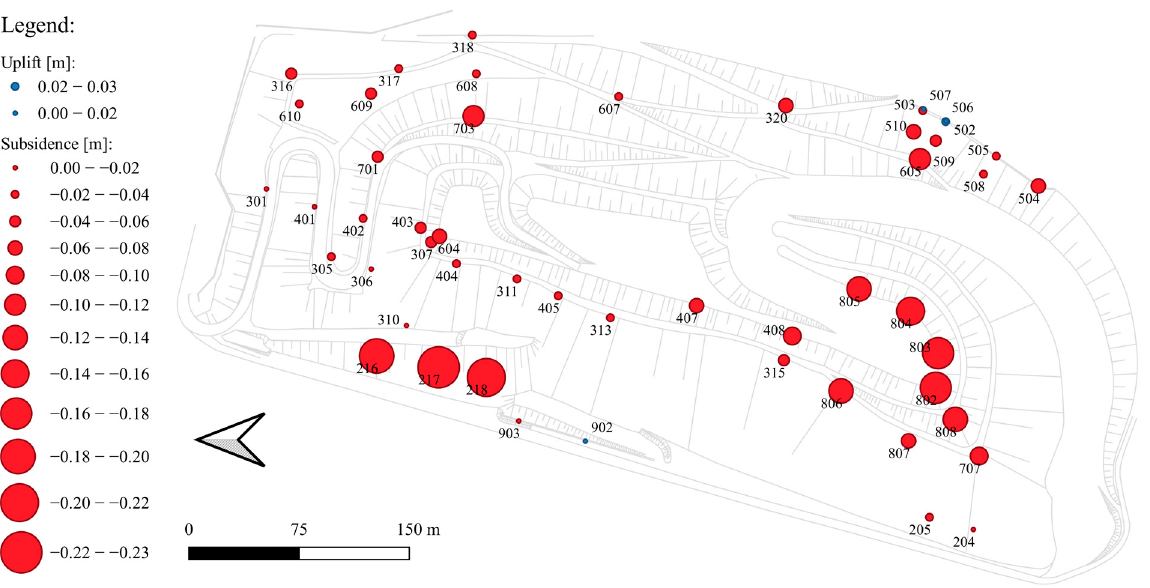
Figure 2. Map of annual subsidence and uplift of control points (December 2020–December 2021) [7].